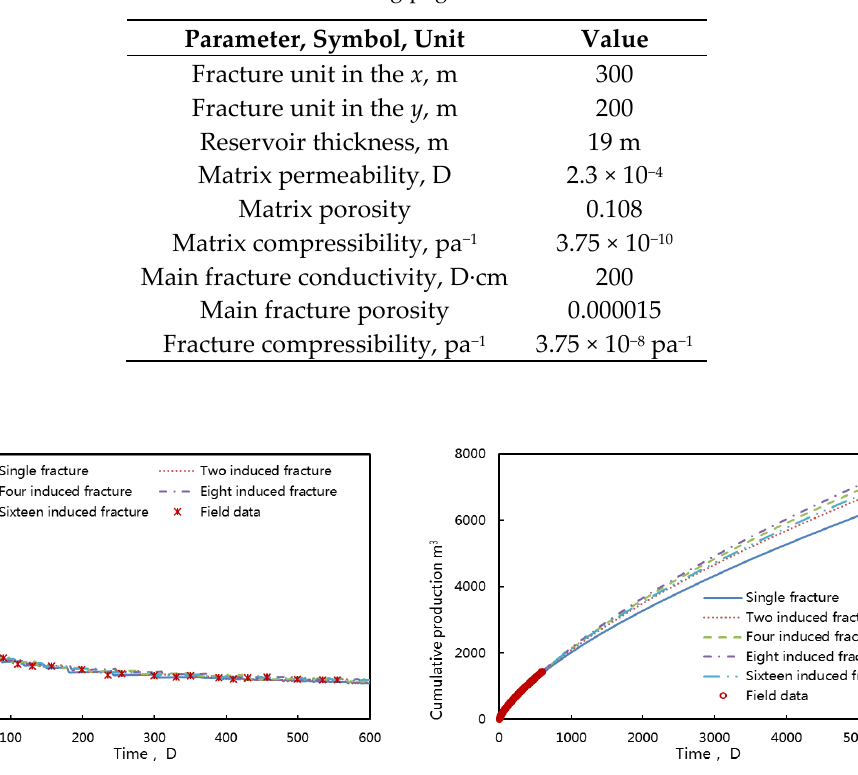
Table 1. Changqing oil field data.